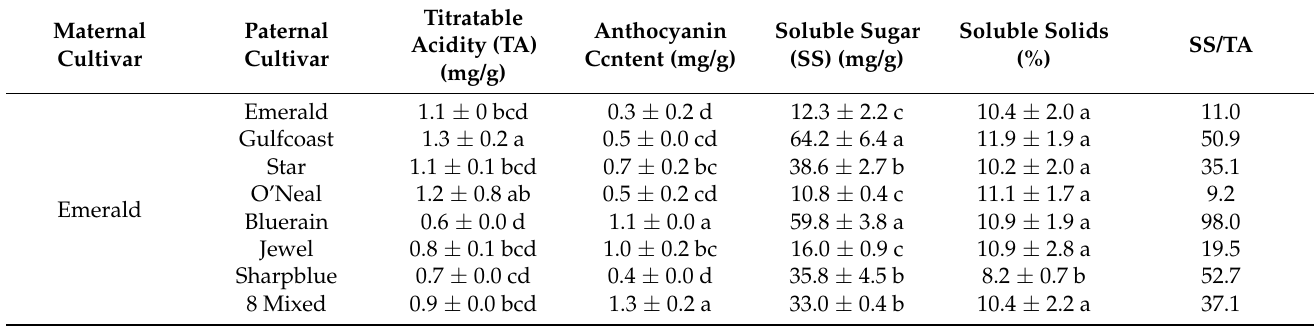
Table 2. Xenia effects on the interior quality of SHB